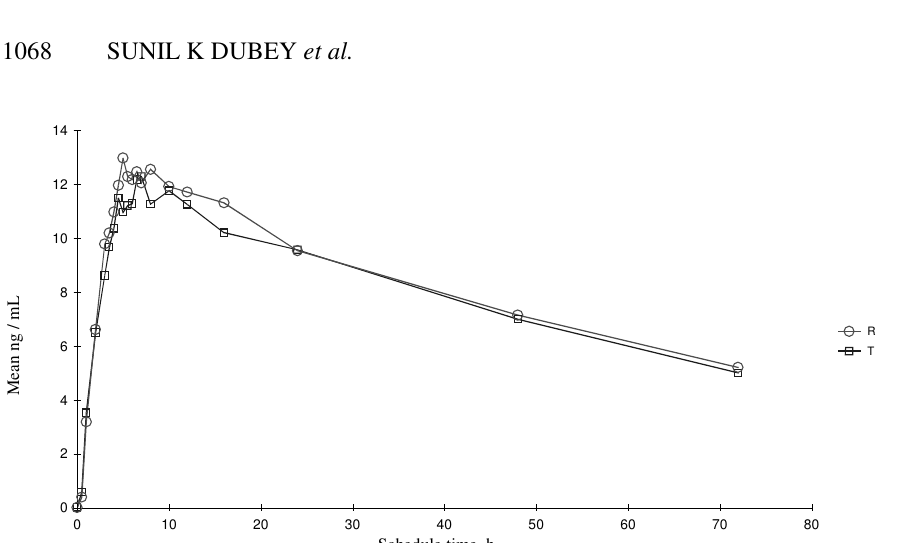
Figure 4. Linear plot of mean concentration vs . time of memantine in plasma.